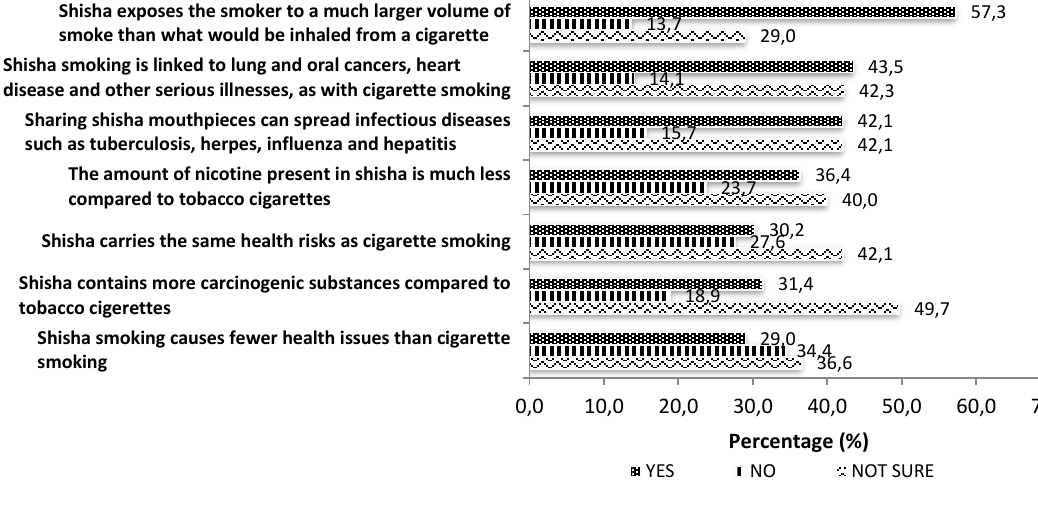
Figure 3. Adverse health effects associated with shisha use ( N = 503).